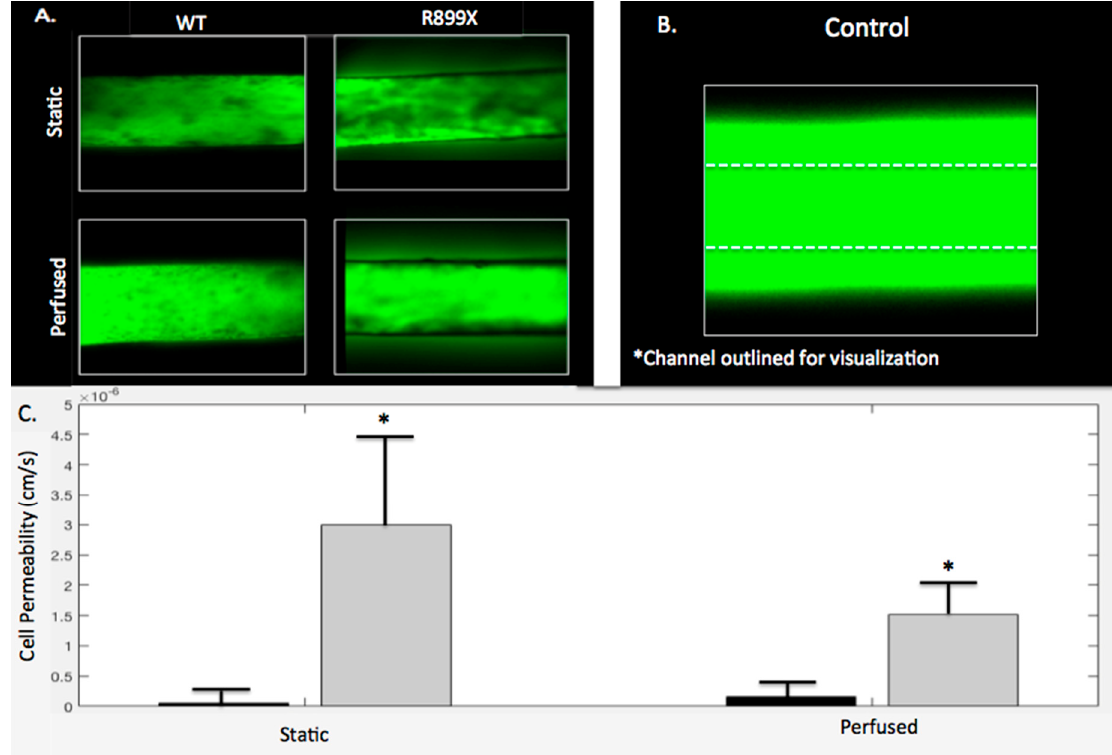
Figure 7. Bmpr2 R899X MPMVECs have increased permeability compared to WT cells under both perfusion and static conditions. ( A ) Static and perfused WT and Bmpr2 R899X channels were imaged at 5× magnification following one hour perfusion with FITC dextran. The channel diameter is 900 µm ( B ) A control channel without cells was perfused with FITC dextran for comparison. Because of excessive fluorescence due to high permeability, the outline of the channel was added. ( C ) Permeabilities of the WT and Bmpr2 R899X are plotted under both conditions to visualize magnitude differences in permeability between genotype. No statistical difference was seen between perfusion and static conditions in all genotypes ( p > 0.05); however WT and Bmpr2 R899X channels had significantly different permeabilities under both static and perfusion conditions ( p < 0.05). N = 3 for all cells ( Bmpr2 R899X and WT) in all conditions (static and perfused).